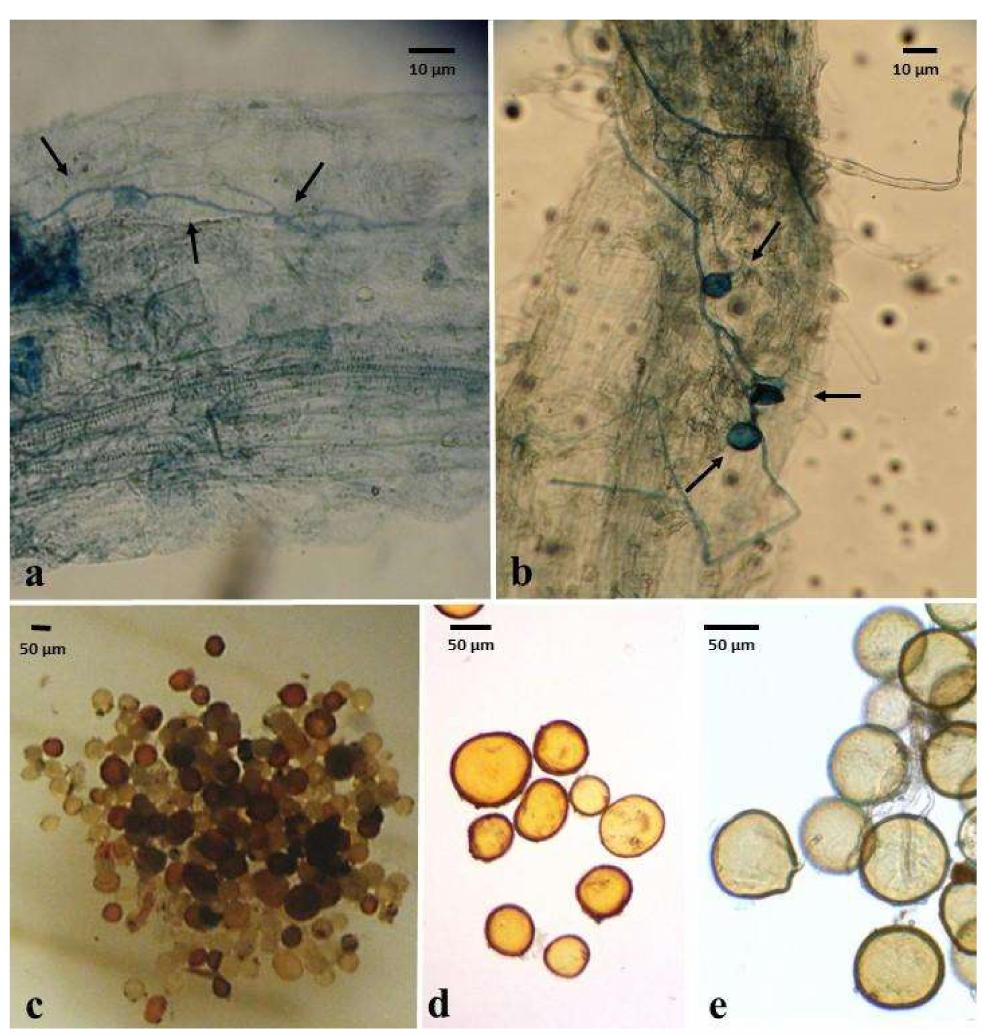
Figure 1. Hyphae, vesicles, and spores of arbuscular mycorrhizal fungi (AMF). Abbreviations: con- sortium of autochthonous AMF of the Agave maximiliana rhizosphere (Cn), Claroideoglomus etunicatum (Ce), and Claroideoglomus claroideum (Cc) ( a ) AMF hyphae in the roots of A. maximiliana roots after six months of treatment (Cc). ( b ) AMF Hyphae and vesicles in A. maximiliana roots after 12 months of treatment (Cn). ( c ) Spores of Cn. ( d ) Spores of Ce. ( e ) Spores of